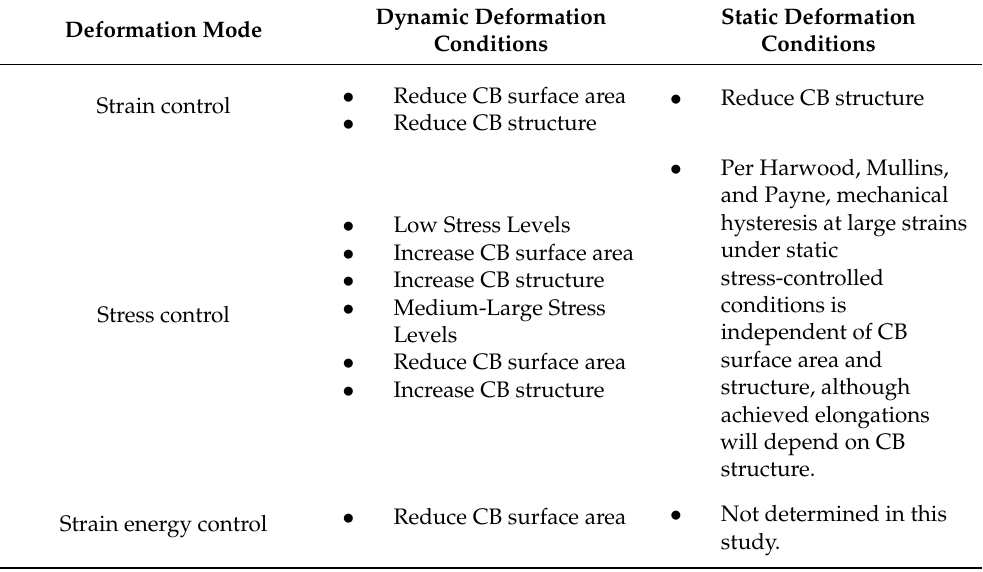
Table 5. Summary of CB selection recommendations to minimize mechanical hysteresis based on strain sweep and cyclic tensile tests.